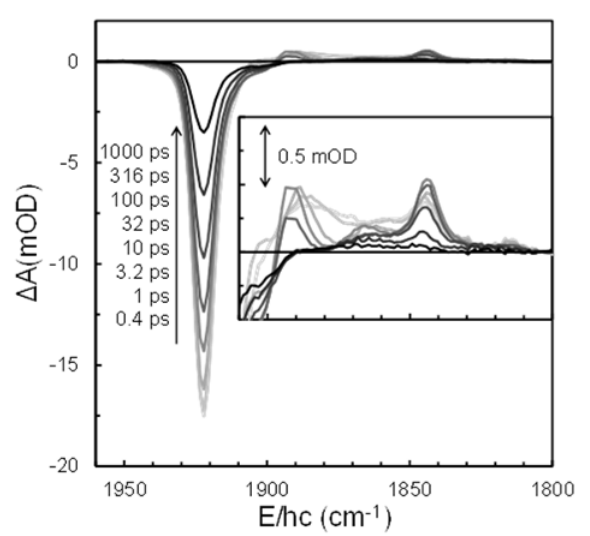
Fig. 1. Time-resolved vibrational spectra after photoexcitation of Mb III NO in D 2 O solution with a 575 nm pulse at 294 K. Inset is the expanded view to show small but significant new absorption features in lower energy side of the main